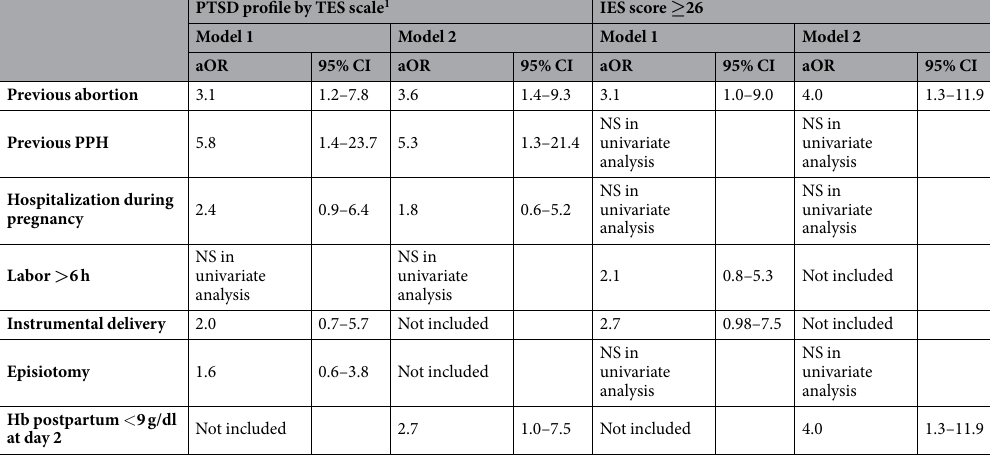
Table 4. Multivariate analysis of factors associated with PTSD at one year after vaginal delivery. For each model, variables included are those listed. aOR, adjusted odds ratio; CI, confidence interval; PTSD, post- traumatic stress disorder; IES, Impact of Event Scale; TES, Traumatic Event Scale. 1 Criteria B, C and D on TES.